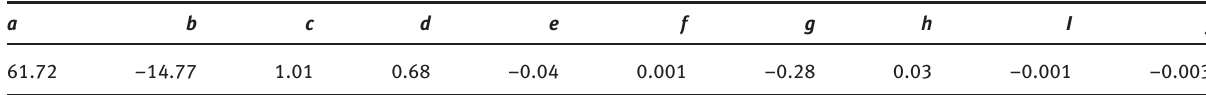
Table 3: Polynomial fitting results of f 1 ð _ ε , T Þ of BR1500HS